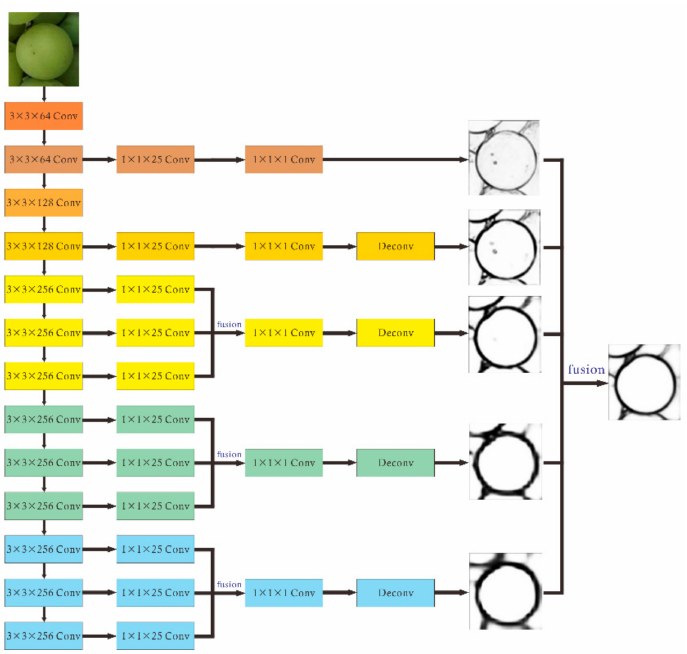
Figure 1. Structure of Improved HED